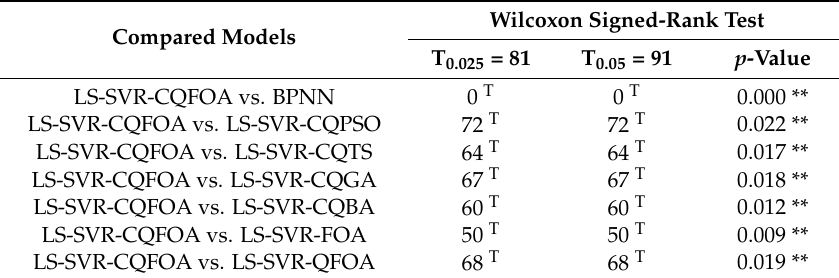
Table 10. Results of Wilcoxon signed-rank test for IDAS 2014.